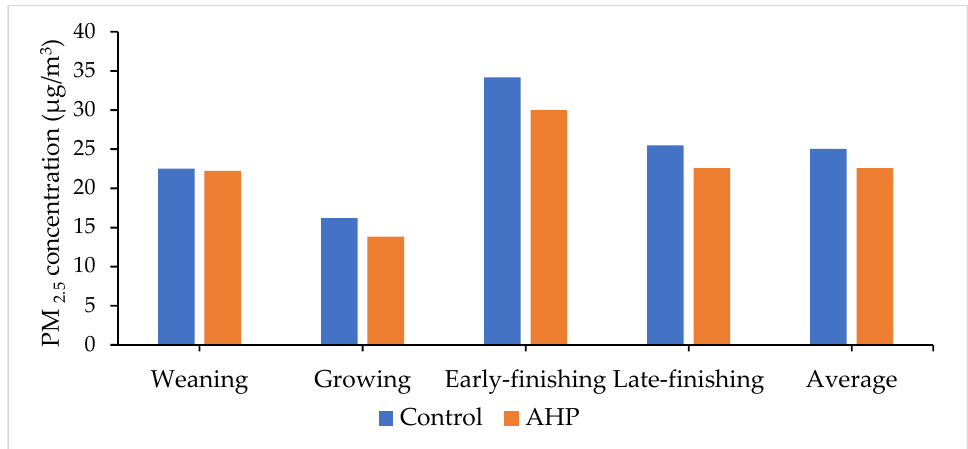
Figure 5. Effect of the AHP cooling system on the fine particulate matter (µg/m 3 ) concentration in the pig house. Data are presented as mean ± SEM.